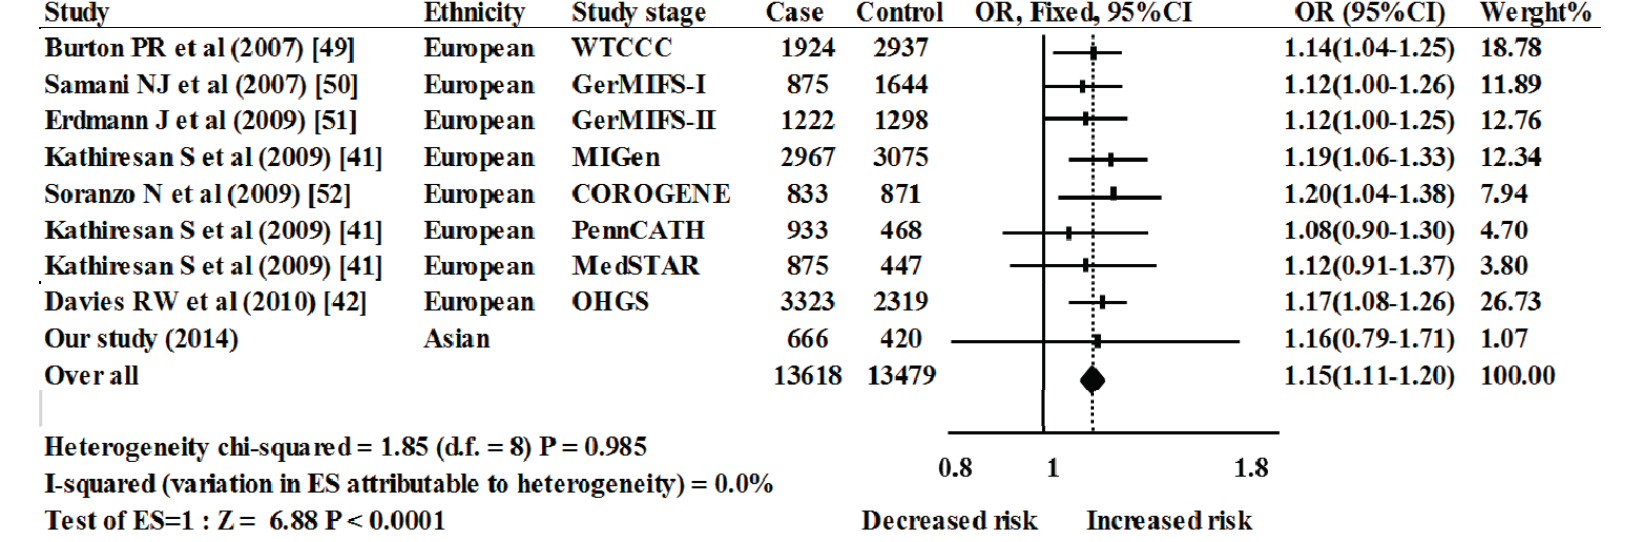
Figure 4. Meta-analysis of 9 association studies between rs11066301 and risk of CAD. WTCCC (Wellcome Trust Case Control Consortium), GerMIFSI (German MI Family Study I), GerMIFSII (German MI Family Study II), MIGen (Myocardial Infarction Genetics Consortium), COROGENE (Corogene study), PennCATH (PennCATH), Medstar (MedSTAR), OHGS (Ottawa Heart Genomics